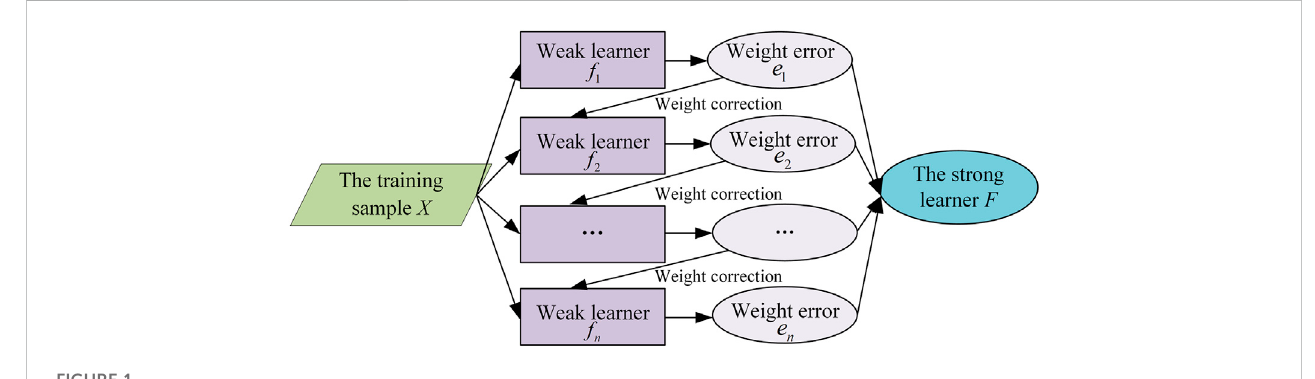
FIGURE 1 Diagram of CatBoost